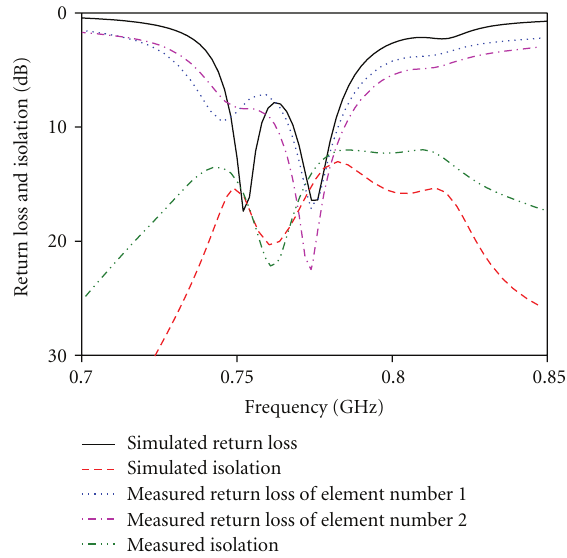
Figure 11: Simulated and measured return loss and isolation char- acteristics of the proposed MIMO antenna.